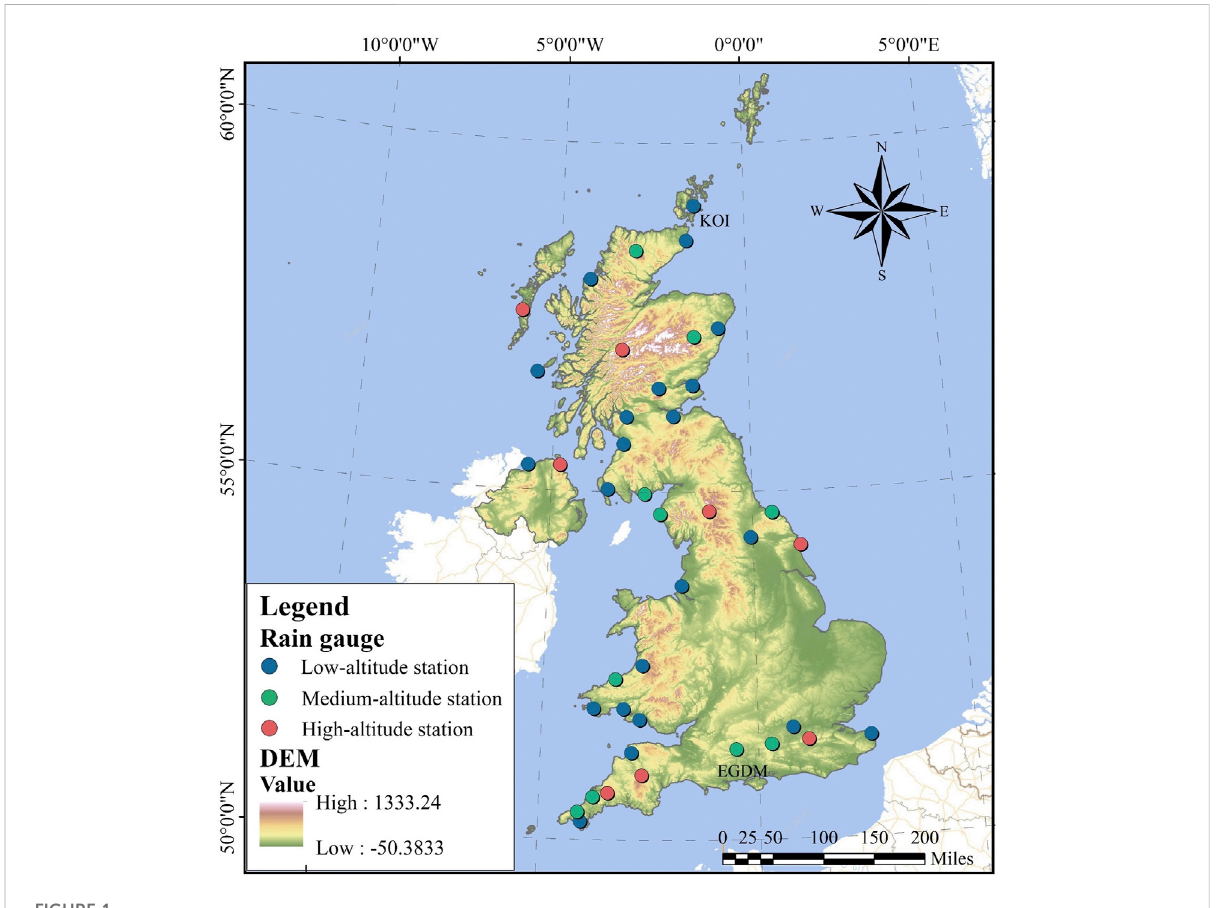
FIGURE 1 Locations of 40 stations in the UK study area with terrain elevation.